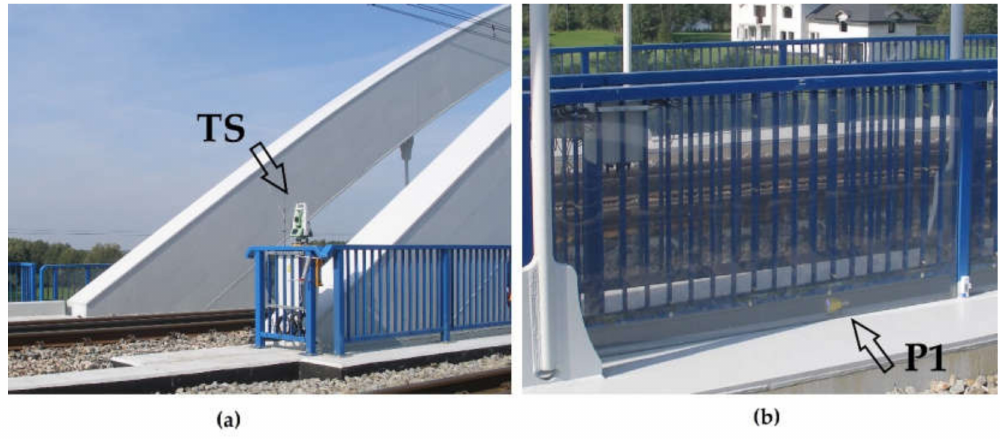
Figure 6. View of the trigonometric survey: ( a ) Total Station TS location; ( b ) prism P1